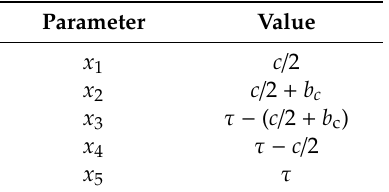
Figure 2. Distribution of equivalent linear current density at the interface of region I and region II. Table 1. Abscissa expression in Figure 2.